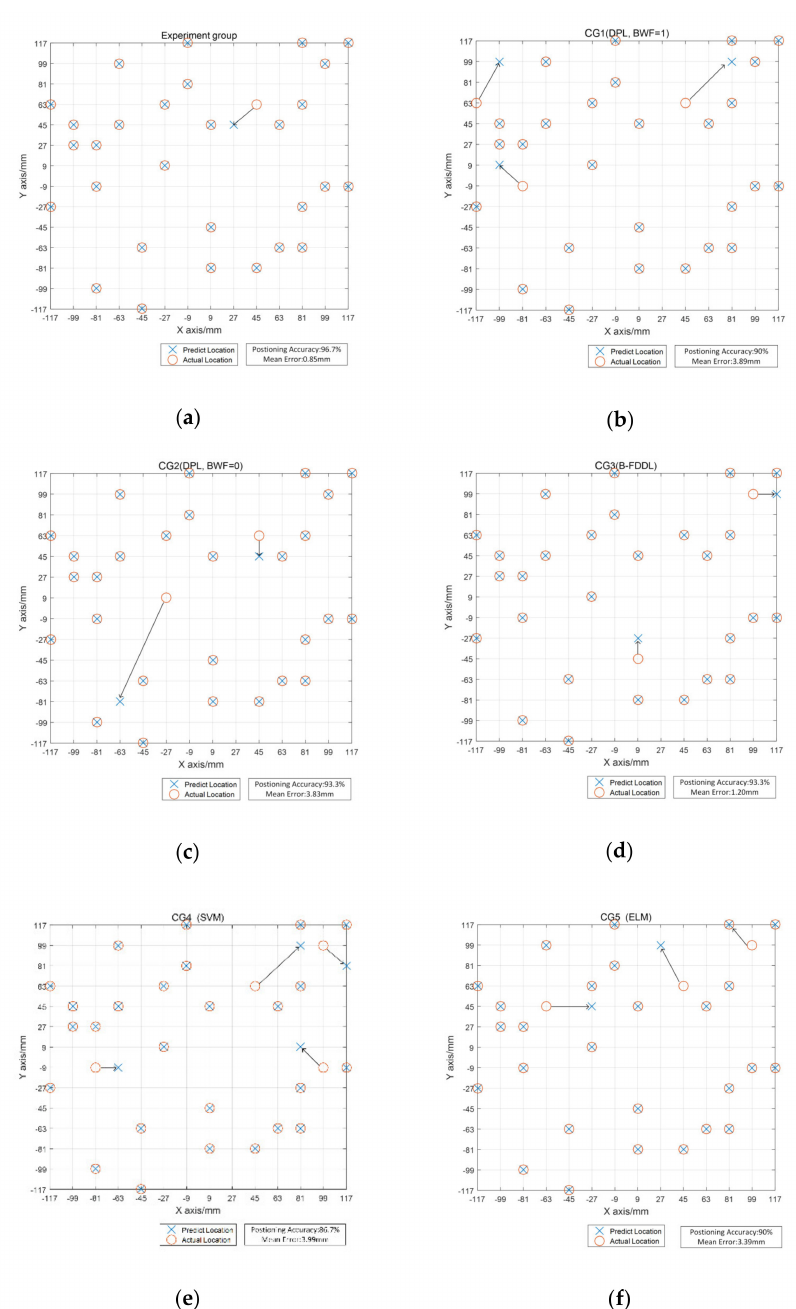
Figure 12. Impact localization results for ( a ) experiment group (B-DPL); ( b ) control group 1 (CG1, DPL, BWF = 1); ( c ) CG2 (DPL, BWF = 0); ( d ) CG3 (B-FDDL); ( e ) CG4 (SVM); ( f ) CG5